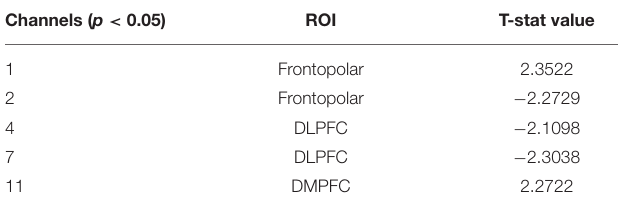
TABLE 4 | Deoxyhemoglobin contrast results between GLM output of low transparency and high transparency conditions (T Low R Low + T low R High )-(T High R Low +T High R High ). Channels ( p < 0.05)